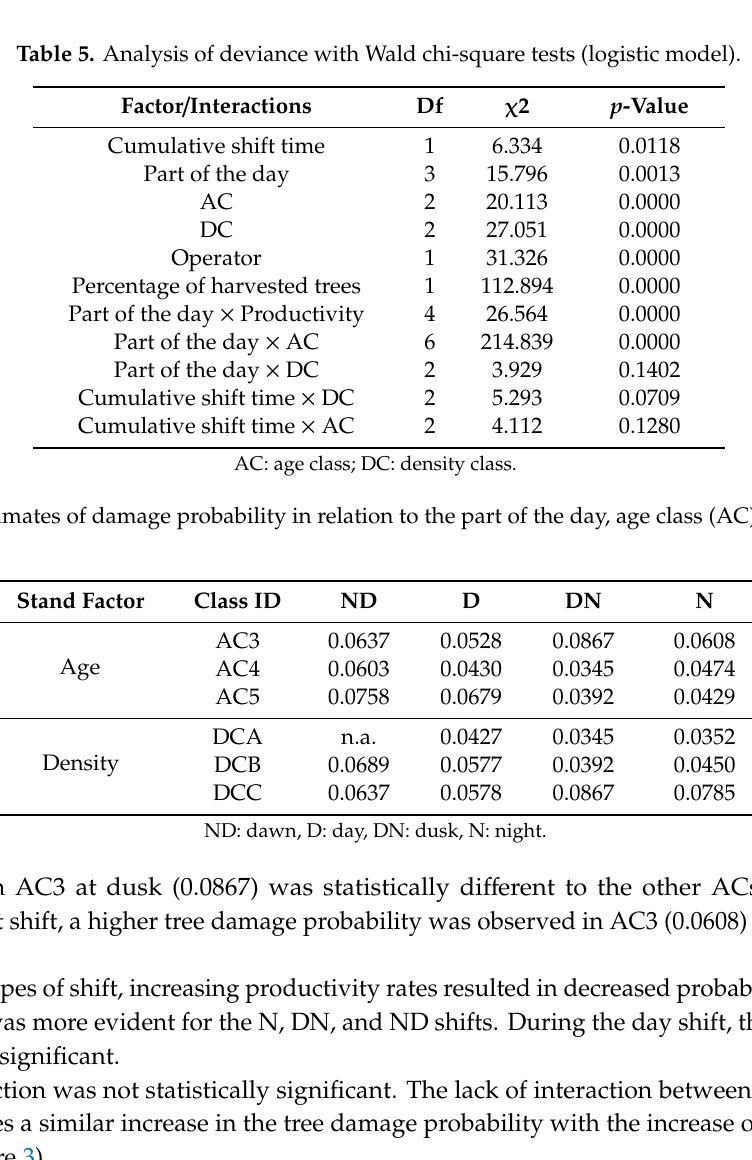
( b ) Figure 4. Tree damage probability as a function of the cumulative shift time with respect to: ( a ) age class, and ( b ) density class. Finally, an additive logistic model was built (Table 7) with the following factors/variables: time of shift, operator, type of shift, AC and DC.